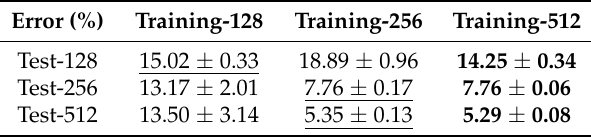
Table 5. GSD prediction errors according to the training and test image sizes with the log GSD scale dataset 1.